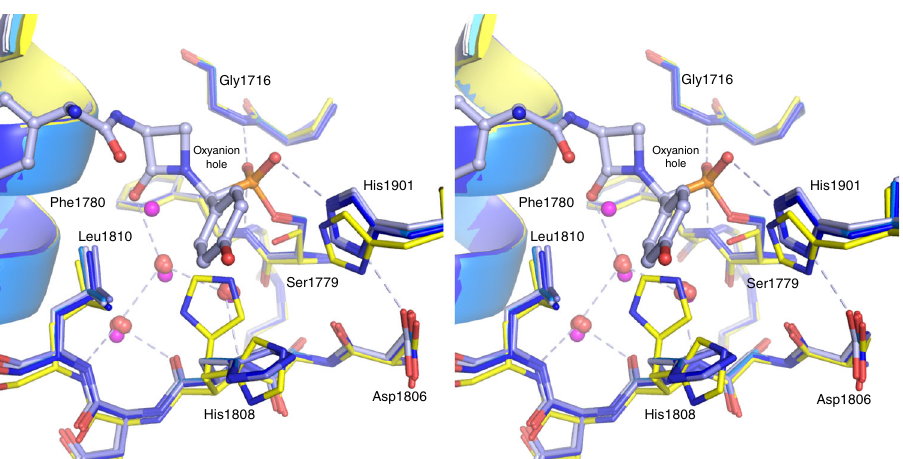
Fig. 5 Water network of the NocTE active site. Four chains of the inactivated NocTE (shown in different shades of blue) were superimposed on unliganded NocTE (yellow). Water molecules that fi ll the putative L-Hpg pocket are shown as spheres from the liganded (red) and unliganded (pink) structures. The side chain of His1808 adopts alternate conformations in the unliganded structure. The covalent adduct formed by reaction with inactivator 4 is shown in ball-and-stick from chain A only. Hydrogen bonds that form the network of interactions among the conserved waters, as well as for the catalytic triad and the oxyanion hole, are highlighted for chain